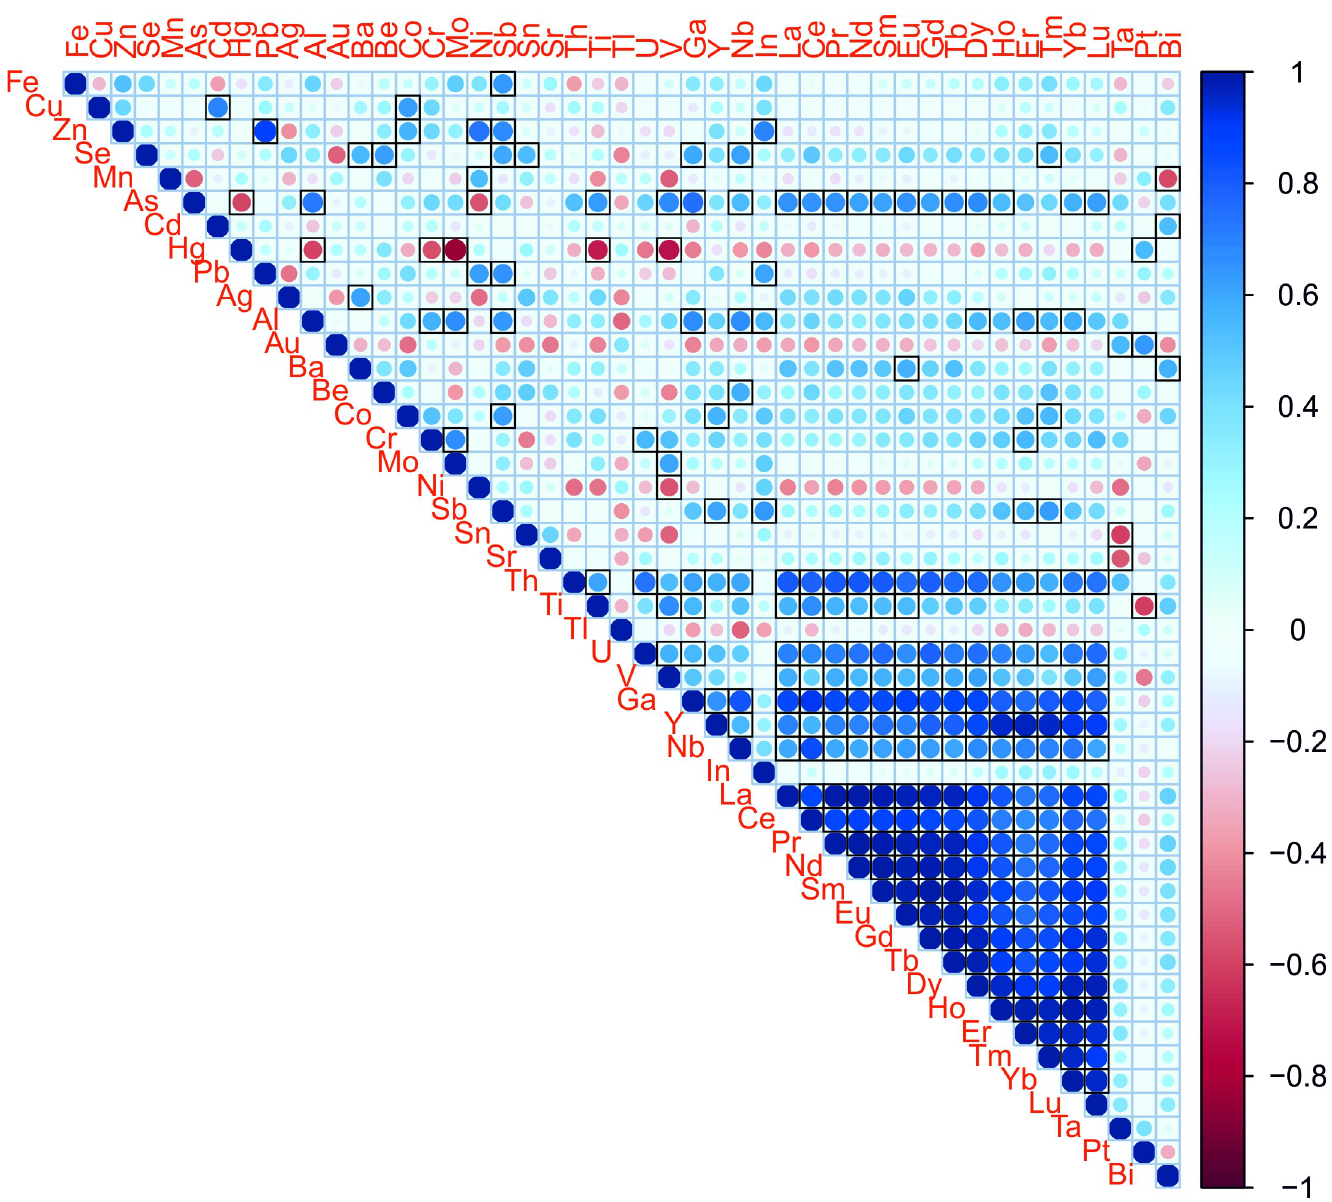
Fig 1. Correlation plot between all pairs of the 47 metal concentration measures obtained. Color scale according to Spearman correlation coefficient (r) and circle size absolute r values. Significant differences (p < 0.05) are black framed. (r > 0.75) were found between rare earth elements and for As, Th, Ti, U, V, Ga and Nb. Hg was negatively correlated with other elements, significantly and strongly (r < -0.75) with Al, Cr, Mo, Ti and V (Fig 1). Wine samples from conventional production tended to have a higher mean concentration for most of the measured elements (with the exception of Zn, Cd, Hg, Pb or Bi), and heterogeneity in the measurements also tended to be higher than in the wine sam- ples from organic management (Fig 2). However, significant differences in concentrations (Wilcoxon rank-sum and signed-rank tests, p < 0.05) between wine samples from conven- tional and organic management were not found for any of the assayed elements.